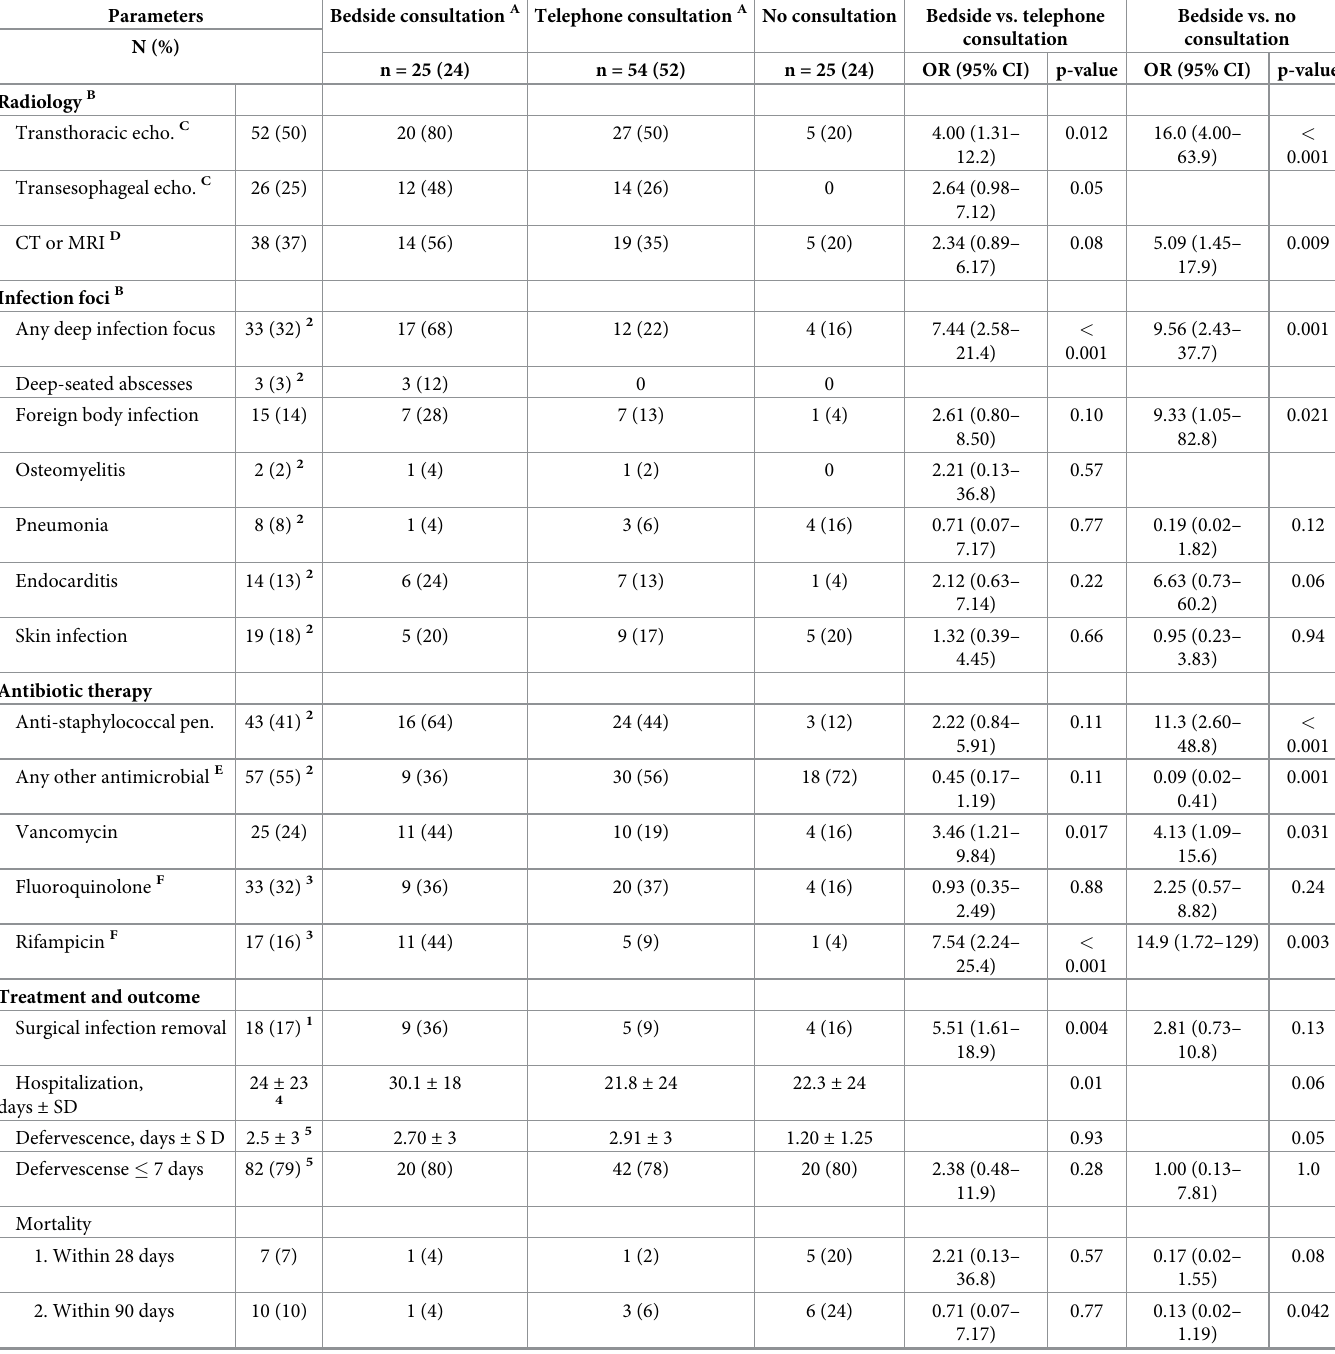
Table 3. Diagnostics, infection foci, antimicrobials and outcome of 104 patients with Staphylococcus lugdunensis bacteraemia stratified according to infectious dis- eases specialist consultation.